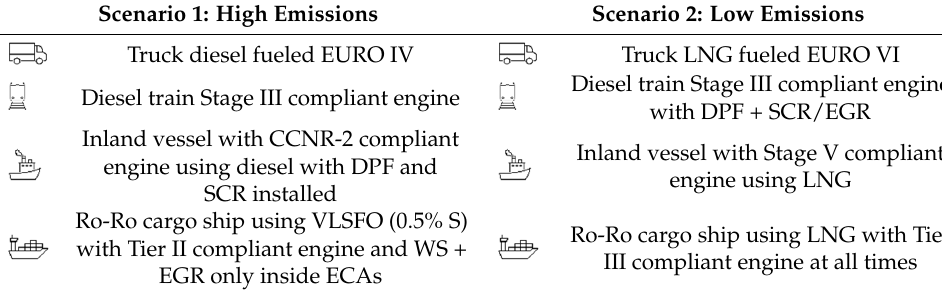
Table 10. Detailed technical characteristics of vehicles used in transport chains. Truck Truck Train Truck Truck